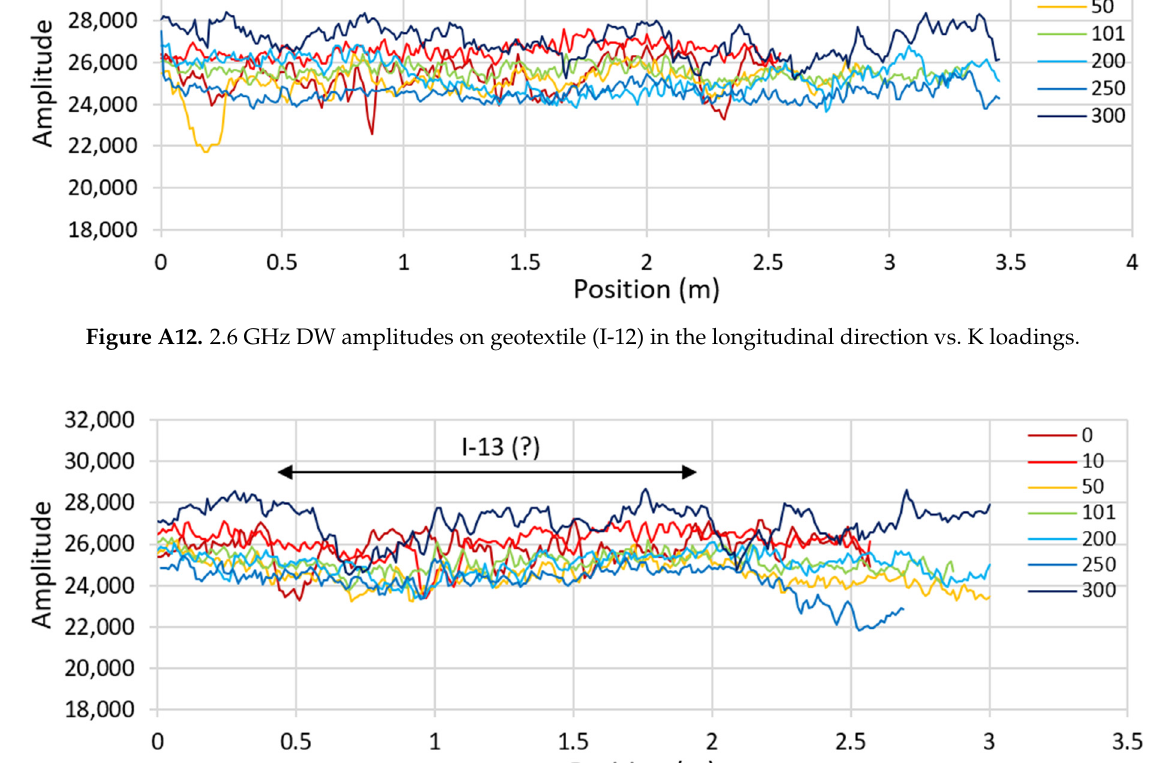
Figure A13. 2.6 GHz DW amplitudes on tack-coat free (I-13) in the longitudinal direction vs. K loadings.